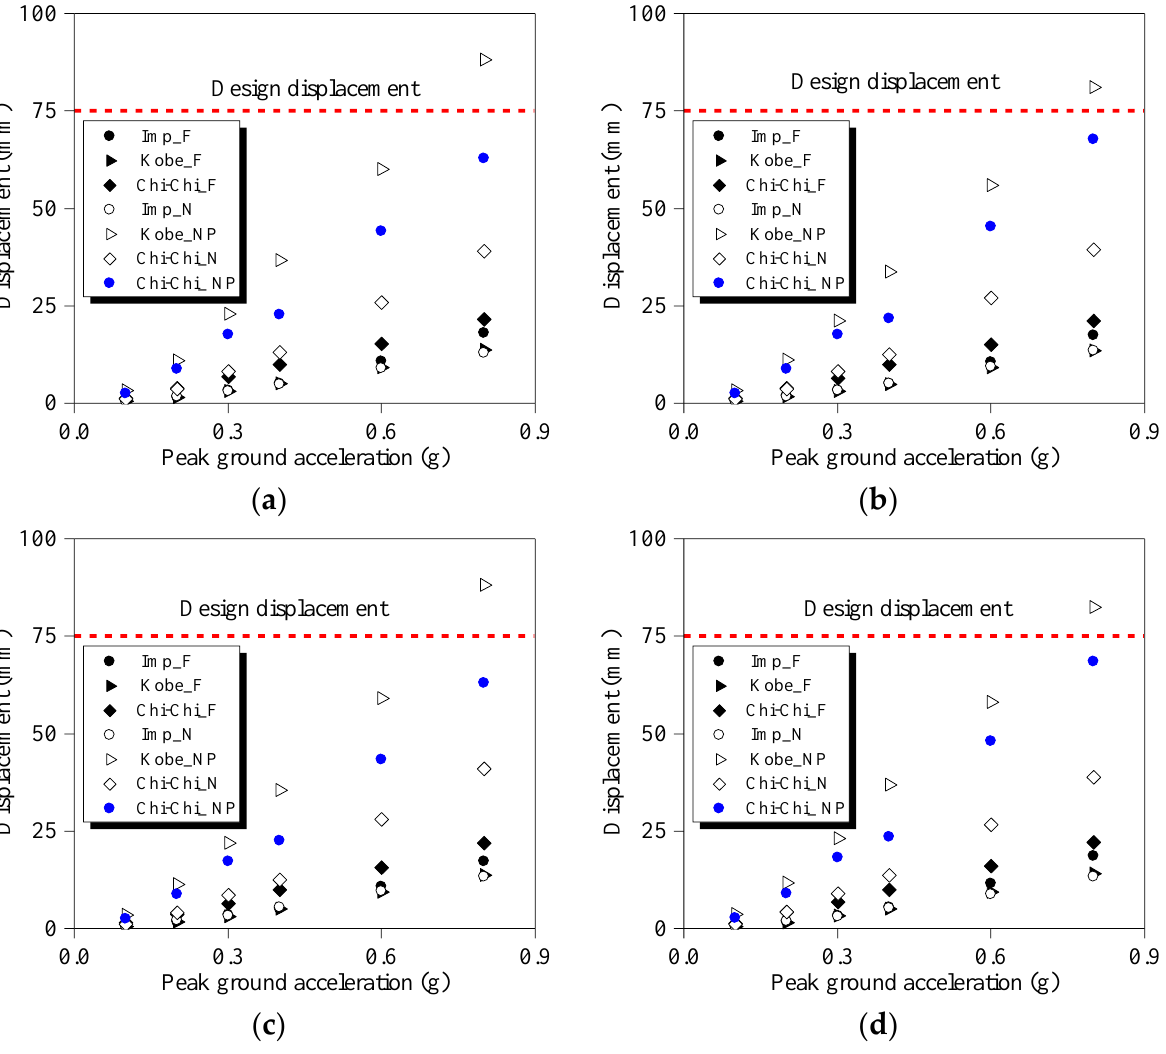
Figure 14. Maximum damper displacement in different earthquake levels: ( a ) northeast location; ( b ) southeast location; ( c ) northwest location; ( d ) southwest location.